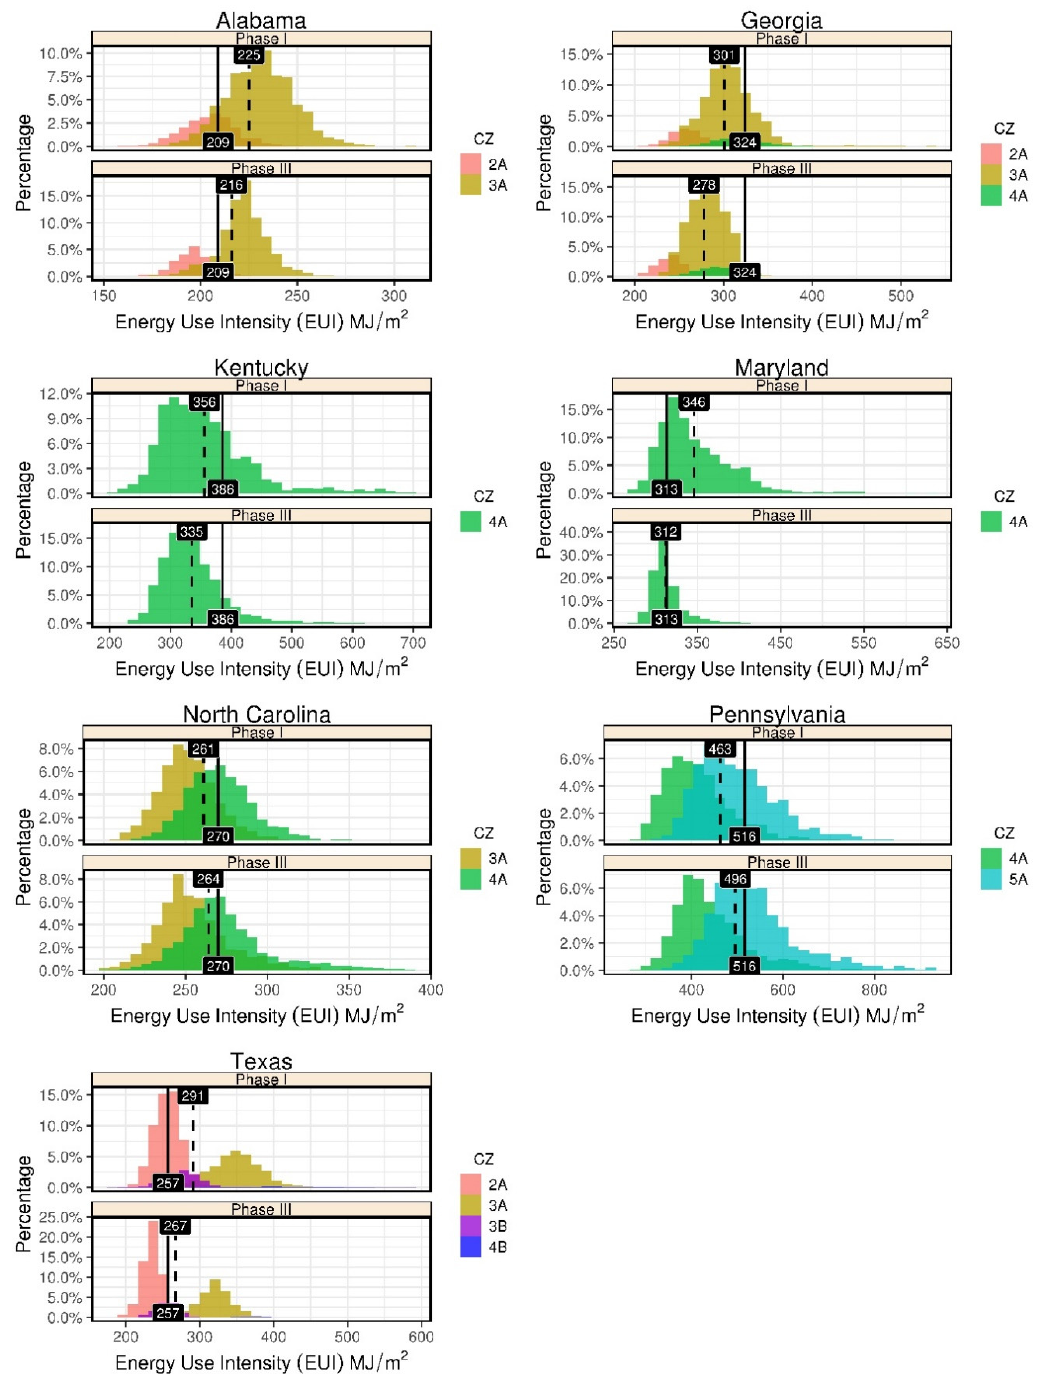
Figure 2. EUI distribution of the regulated loads in the states.